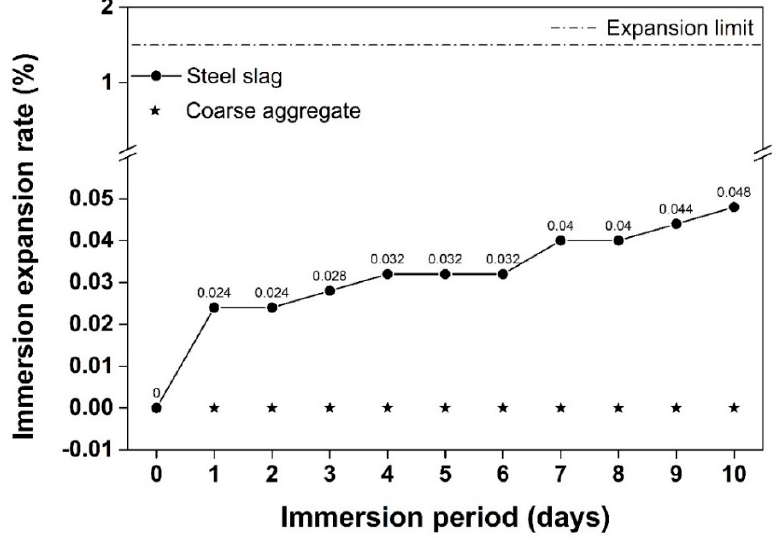
Figure 2. Immersion expansion rates of aggregate.